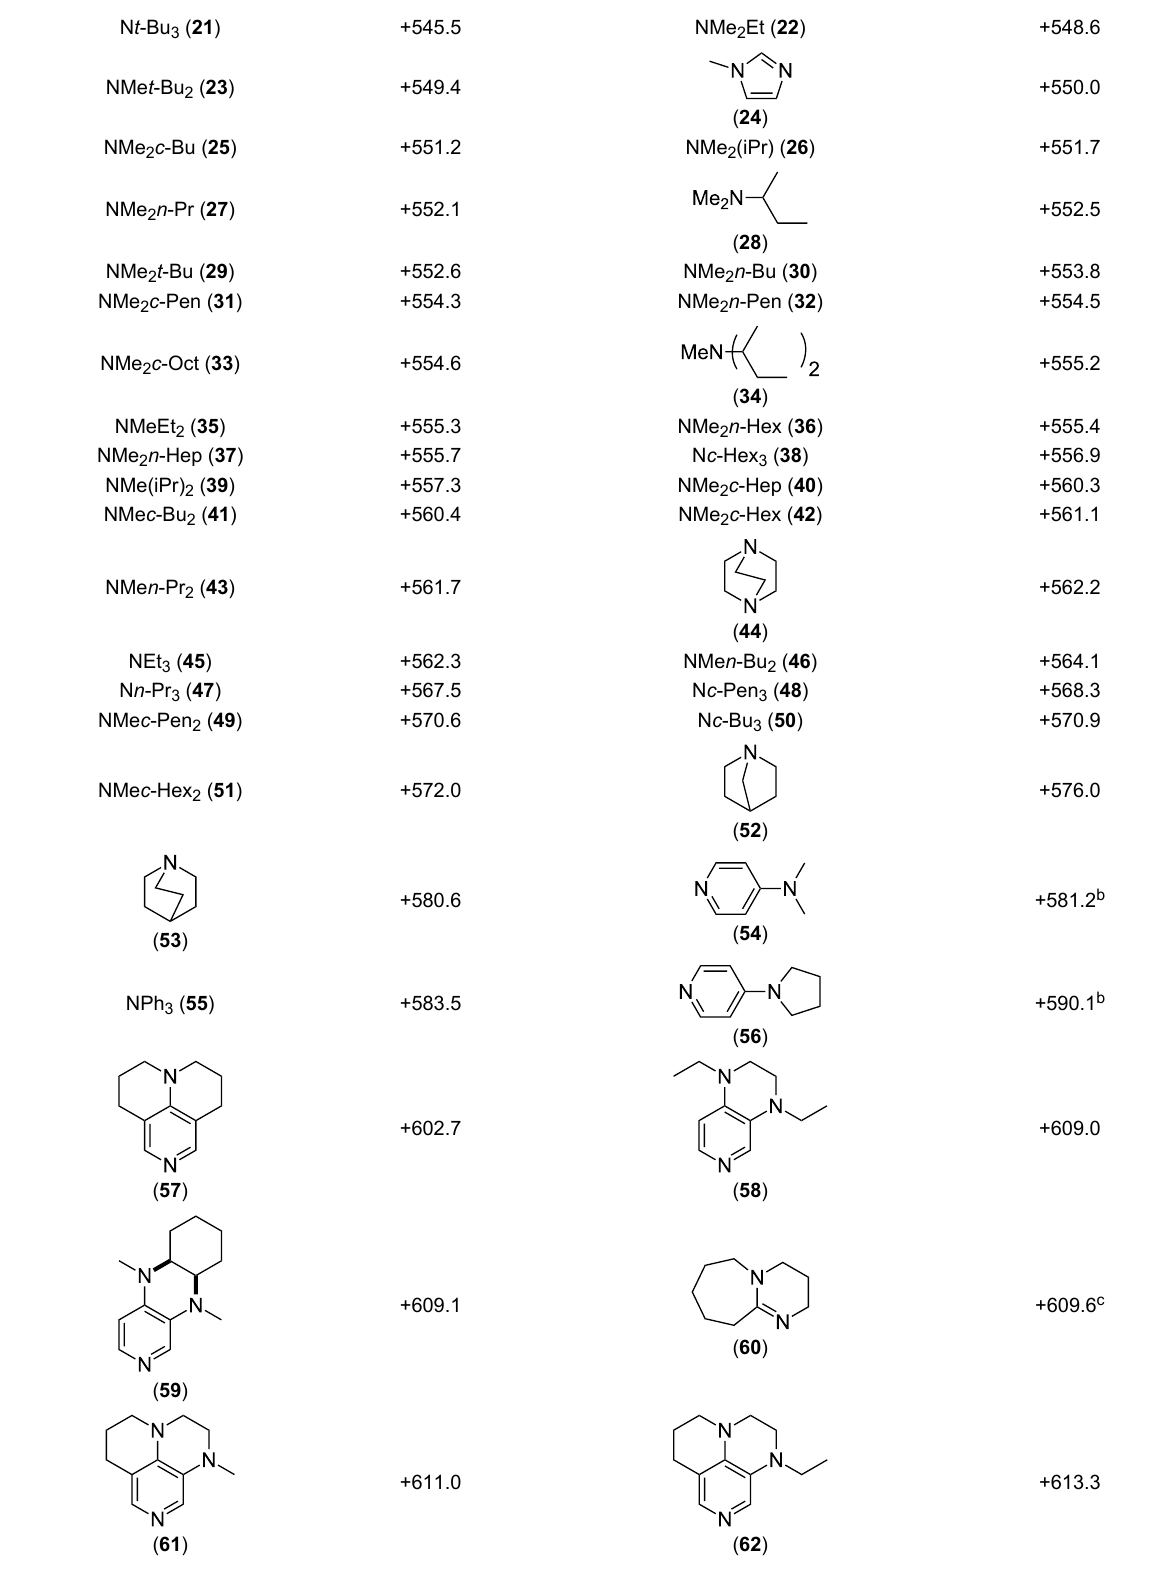
Table 1: MCA values for N-centered Lewis bases, ordered by increasing MCA values.